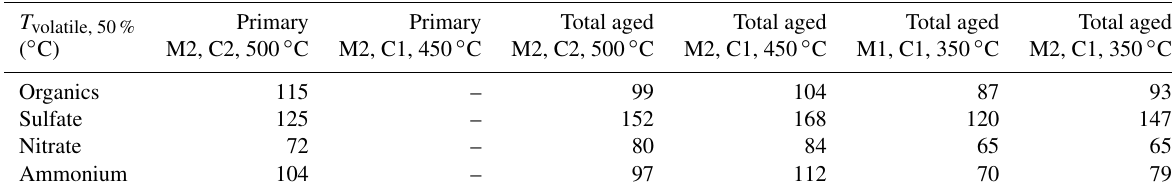
Table 3. The temperatures where 50% of the volatile fraction of species has evaporated. T volatile, 50% Primary Primary Total aged Total aged Organics